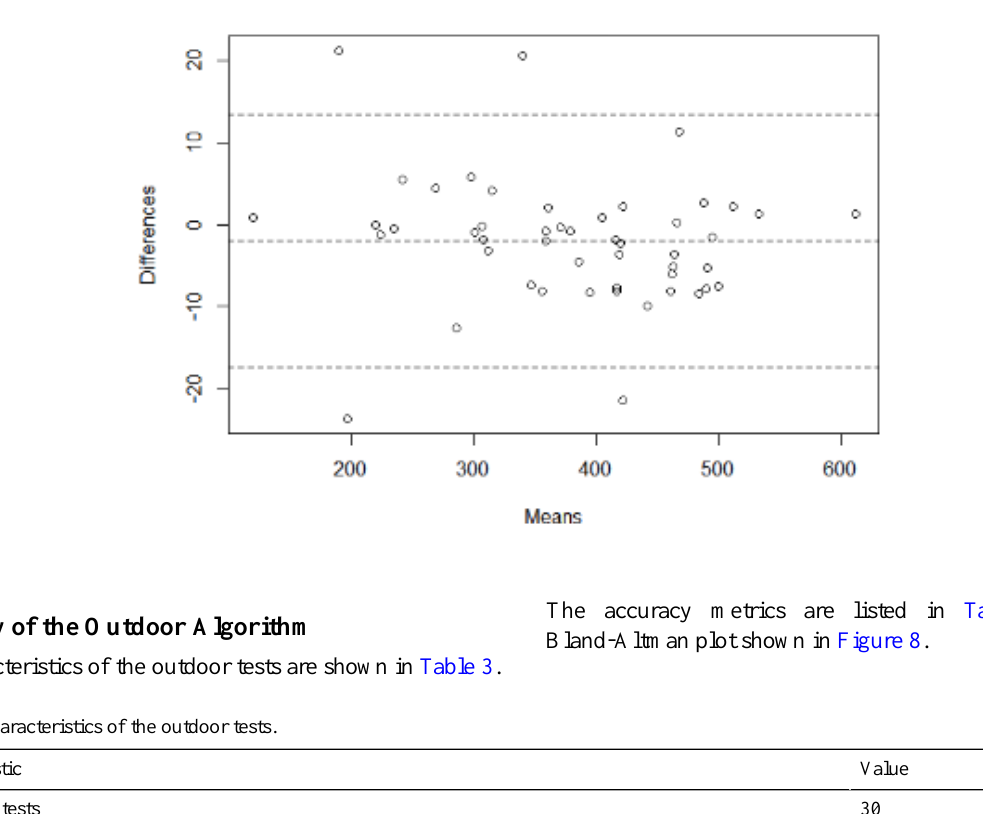
Figure 7. Bland-Altman plot of the difference between the estimated distance walked and the absolute distance. The Shapiro-Wilk test confirms the normality of the data (0.91).